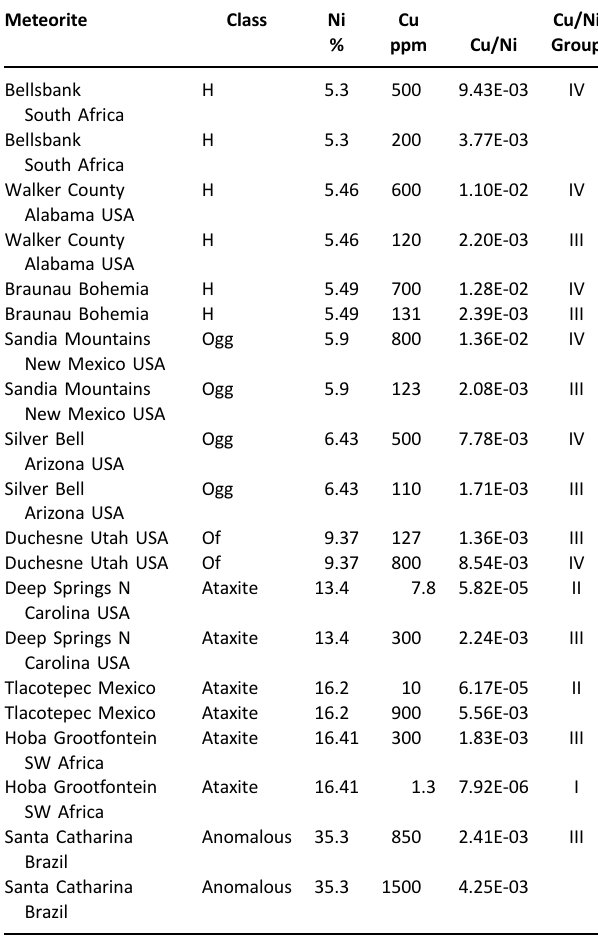
Table 4. Nickel and copper concentration data for iron meteorites exhibiting dual concentration values for Cu (selected data from Table